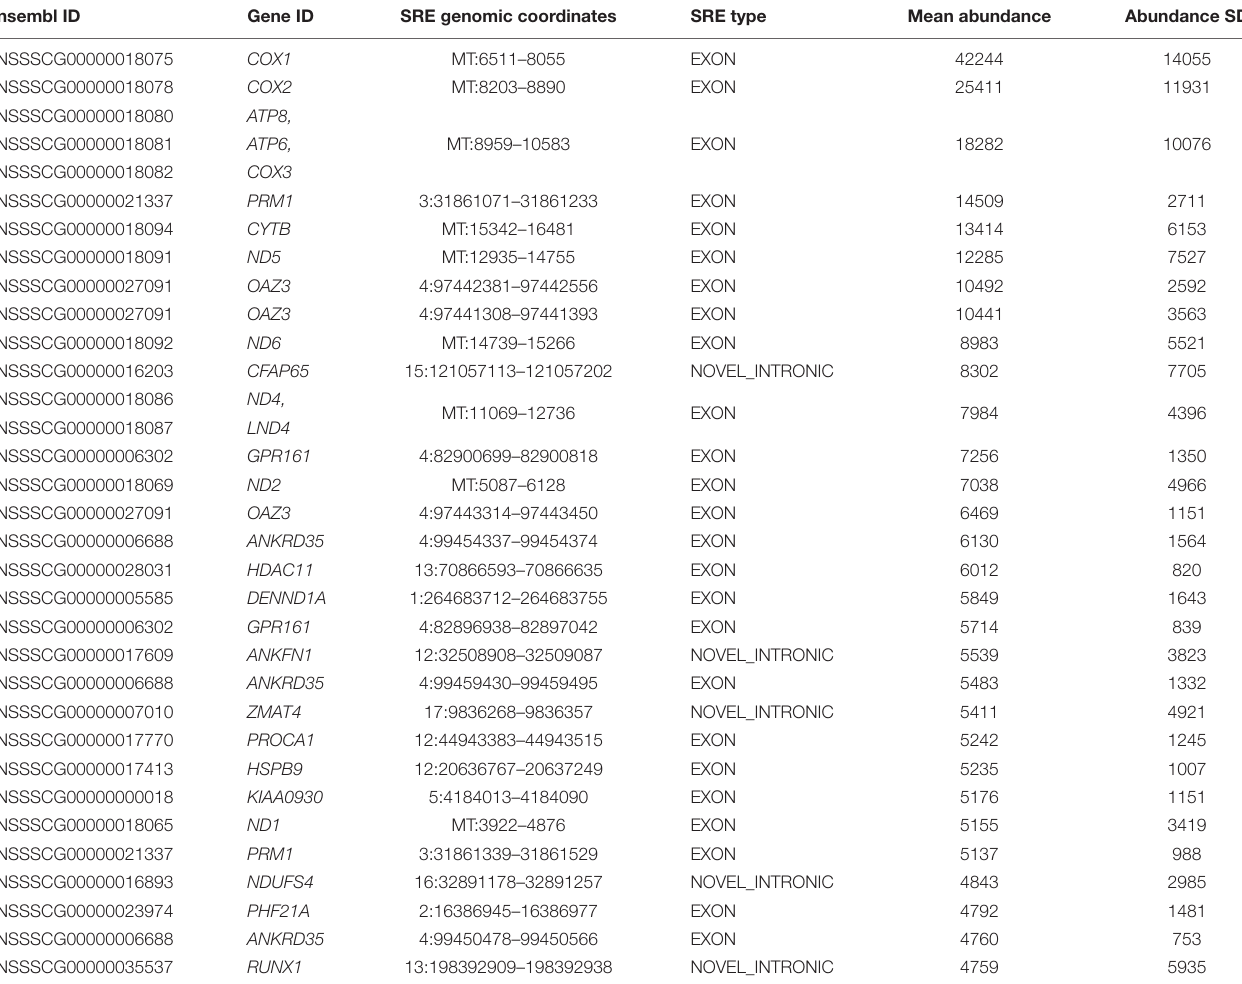
TABLE 1 | List of the 30 most abundant SREs in the porcine